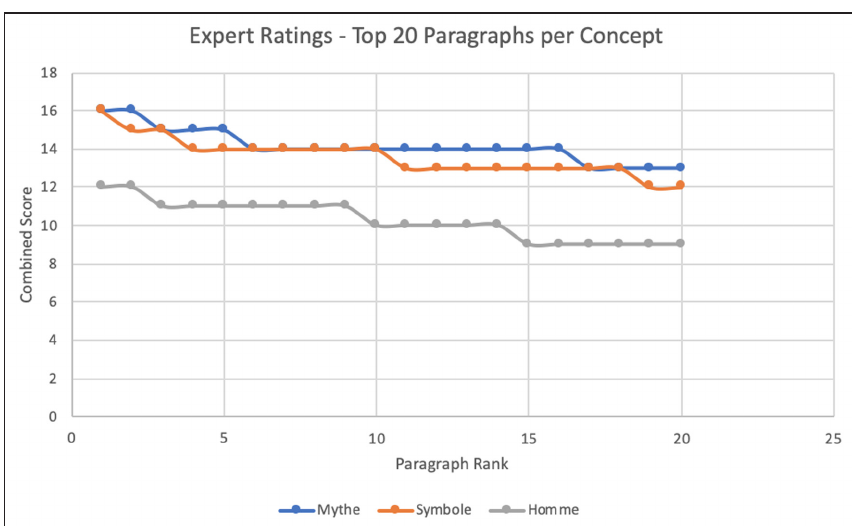
Figure 9: Expert scores for top 20 segments per